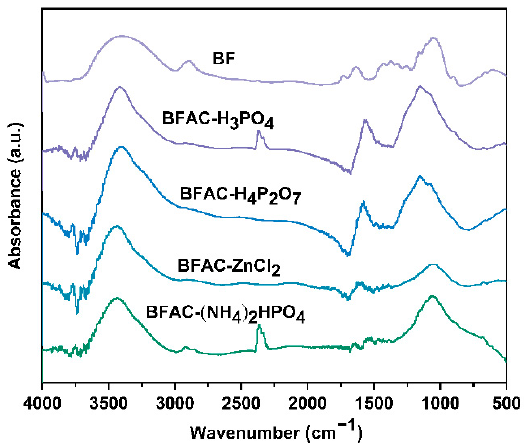
Figure 4. FT-IR spectra of the BFACs activated by different activators and BF.